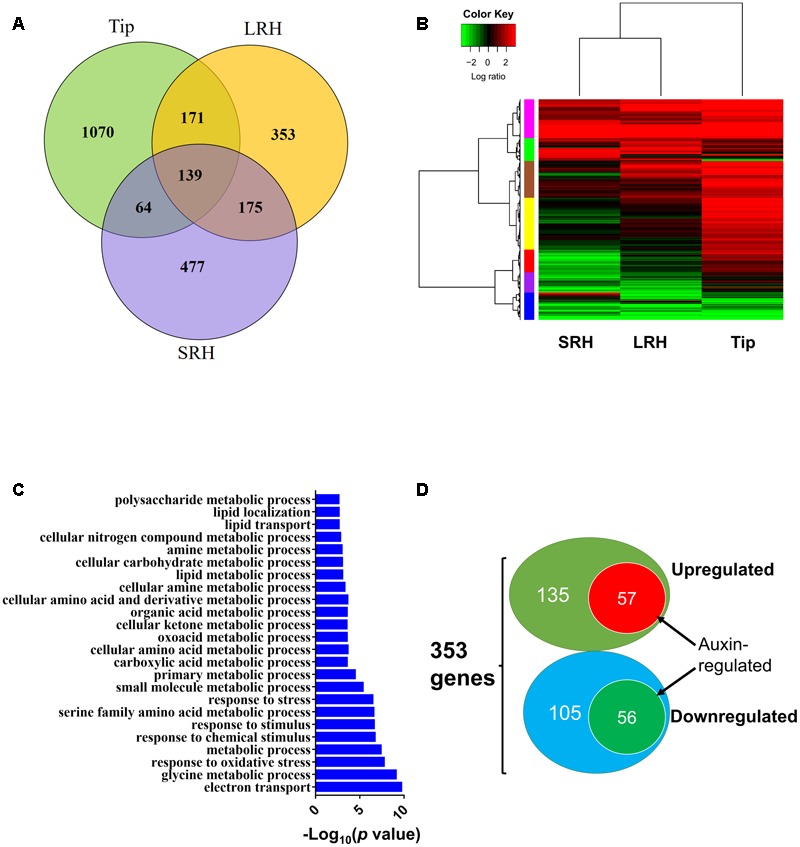
Differentially expressed genes after ABA treatment in the rice root tip (Tip), long root hair (LRH), and short root hair (SRH) zones. (A) Venn diagram showing the differentially expressed genes in the Tip, LRH and SRH zones in response to treatment with 0.5 μM ABA for 24 h. (B) Hierarchical clustering analysis of the differentially expressed genes in the Tip, LRH, and SRH zones with or without 0.5 μM ABA treatment for 24 hrs. (C) GO term analyses shows the biological processes (BPs) enriched in the LRH before and after ABA treatments. (D) Venn diagram showing the overlapping differentially expressed genes regulated by ABA and auxin in the LRH zone. The auxin-regulated genes were based on the RiceXPro database.